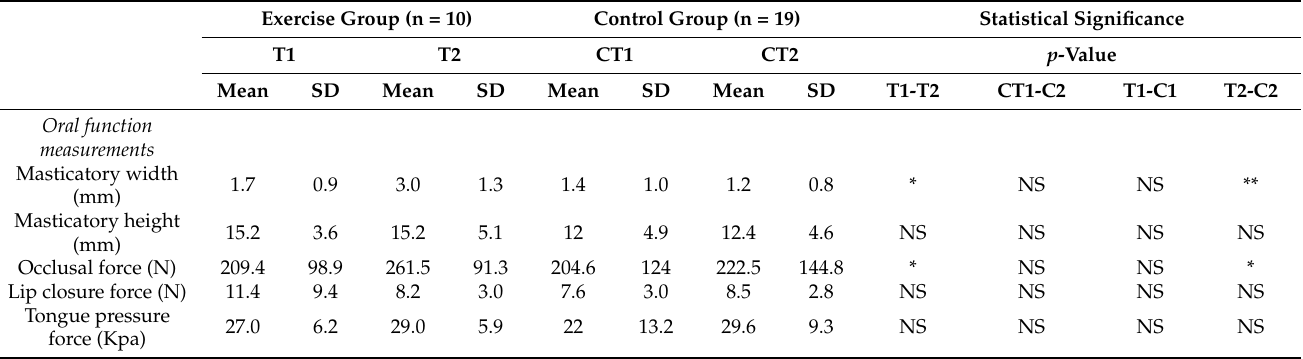
Table 2. Oral function measurements.